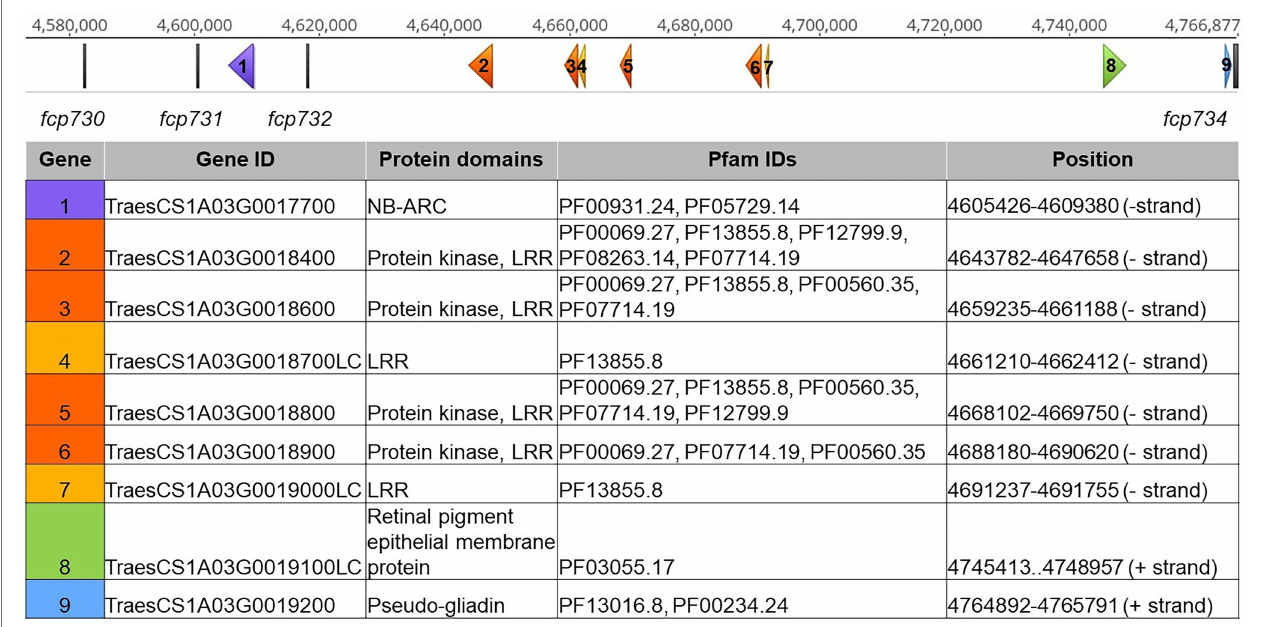
FIGURE 4 | Tsc1 candidate gene region in Chinese Spring reference genome v2.1. The scale on the top represents the physical position in base pairs. Genetic markers are displayed as vertical gray bars. Genes are displayed as arrows, labeled 1–5, corresponding to the genes in the table below. Genes with nucleotide binding and ARC (NB-ARC), protein kinase (PK) and leucine rich repeat (LRR), LRR, retinal pigment epithelial membrane, and gliadin domains are shown in purple, orange, yellow, green, and blue, respectively. Gene IDs, protein domains, Pfam IDs, and physical positions of each gene are included in the